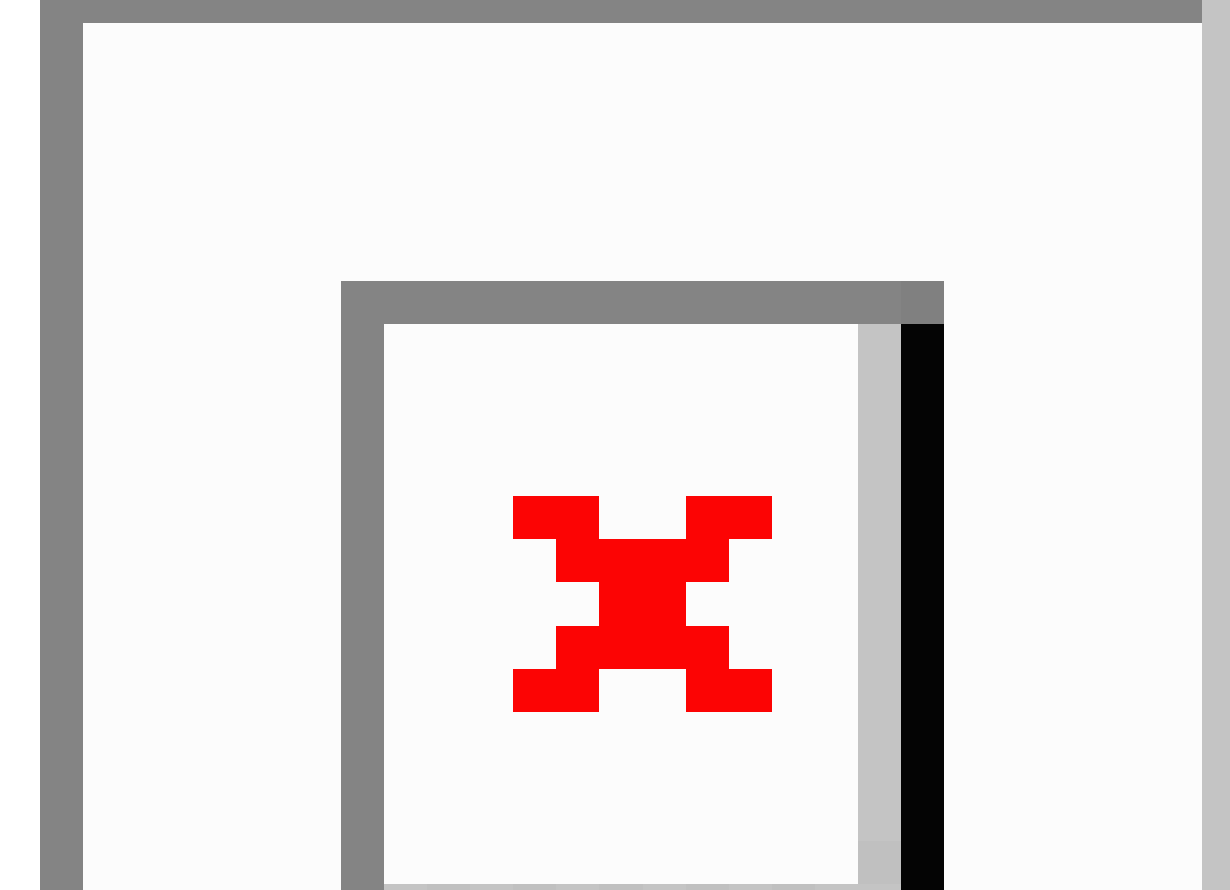
Figure 4. Mean intervention cost (US $) for participants and clinics for the remote and in-person groups. The whiskers represent standard error. The intervention cost incurred by the clinic was